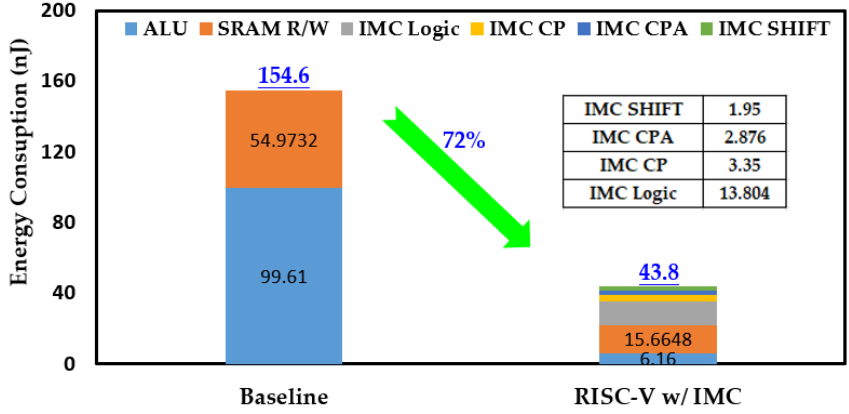
Figure 10. Comparison of energy consumption in one round of Keccak- f permutation.